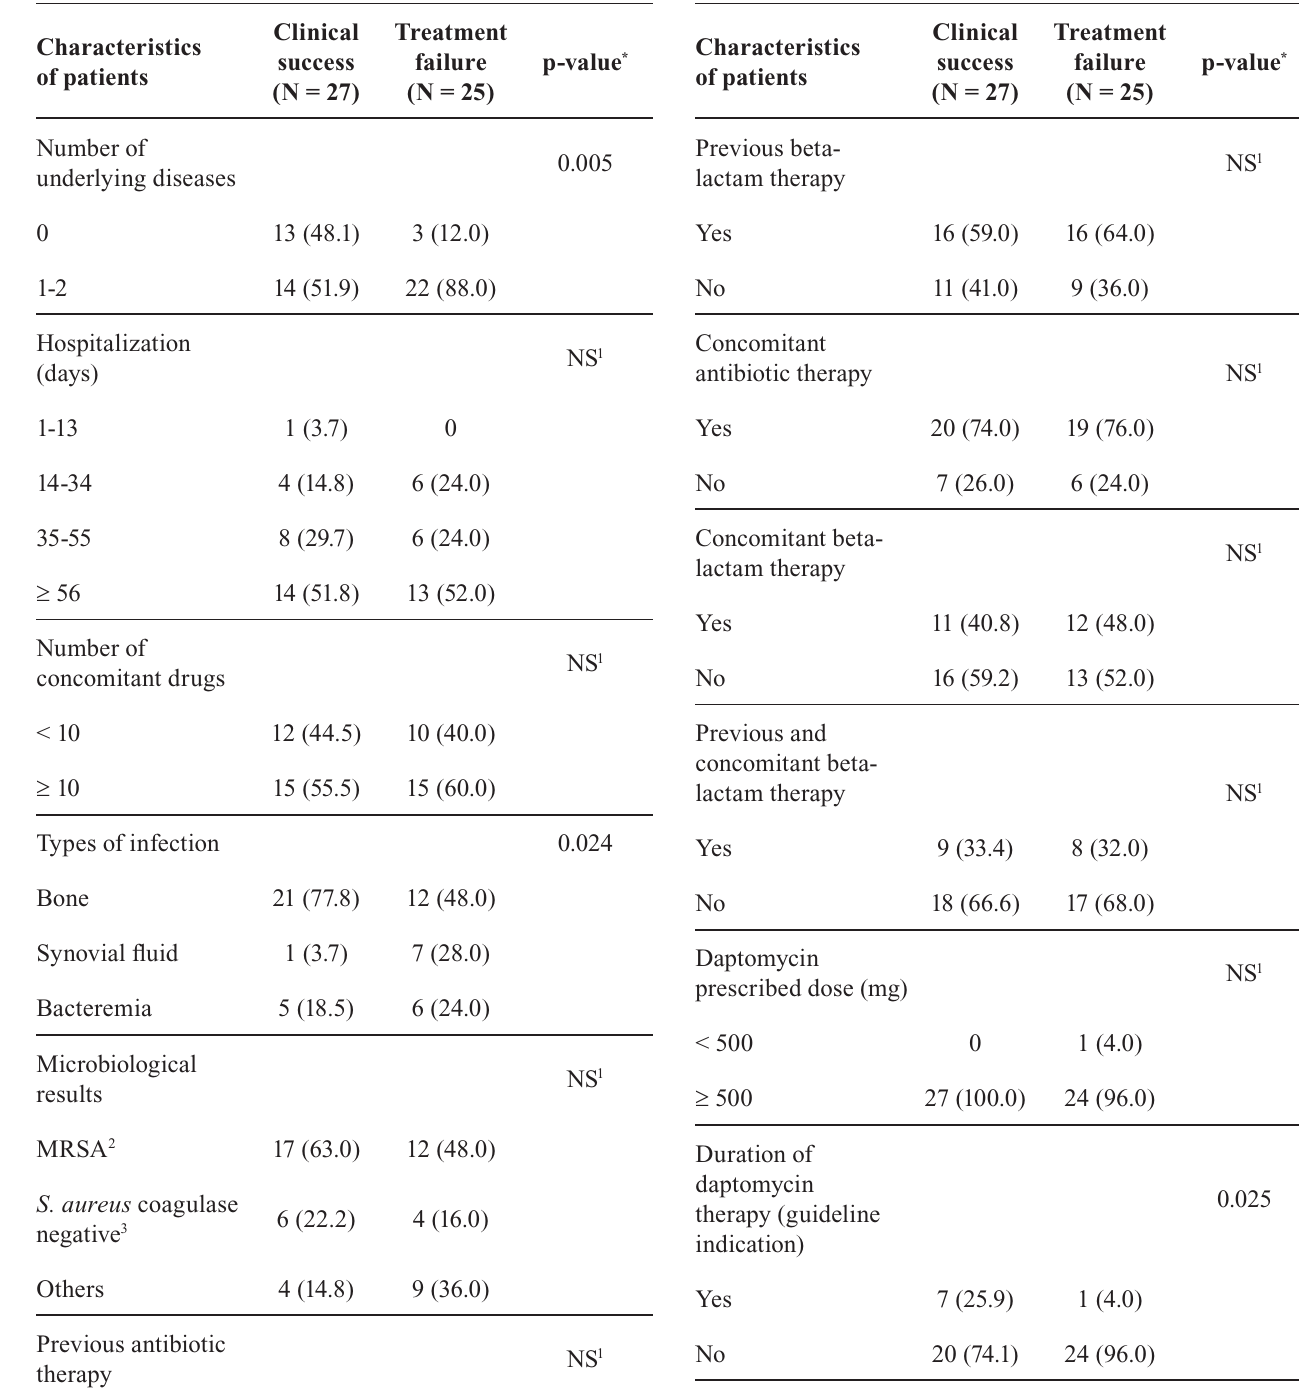
TABLE I - D emographic and clinical characteristics of the 52 patients undergoing daptomycin therapy. Brazil, 2010–14 Characteristics